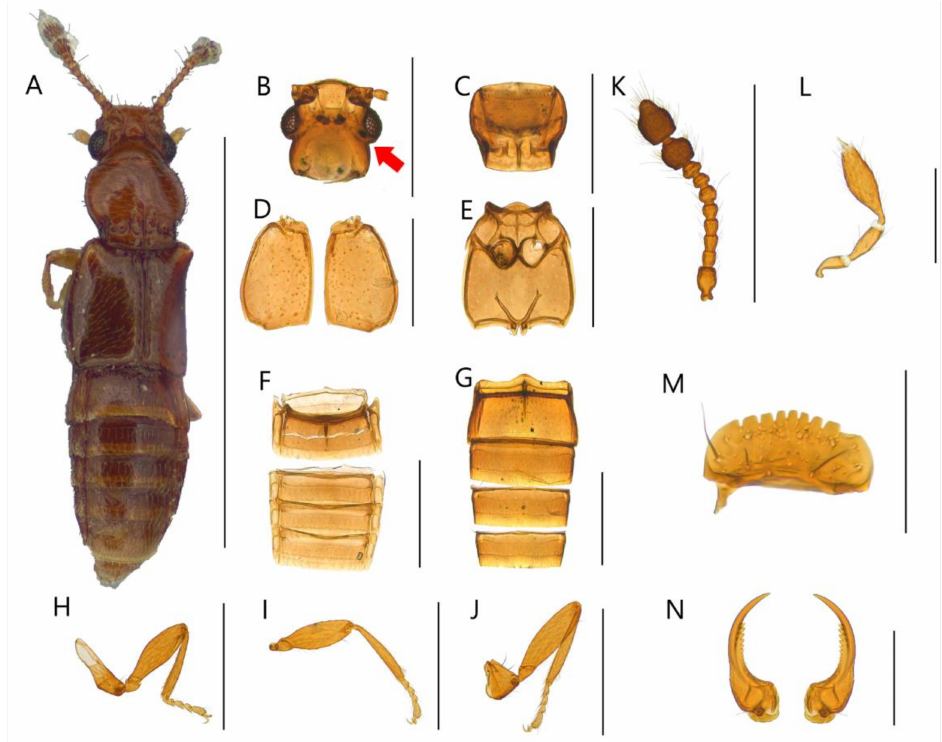
Figure 4. Male habitus of Edaphus suyuensis sp.n.: ( A ) dorsal view; ( B ) head; ( C ) pronotum; ( D ) elytra; ( E ) meso and metasternum; ( F ) abdominal tergites; ( G ) abdominal sternites; ( H ) fore leg; ( I ) middle leg; ( J ) hind leg; ( K ) antenna; ( L ) maxillary palp; ( M ) labrum; ( N ) mandibles. Scale bars: ( A ) = 1 mm; ( B – K ) = 0.3 mm; ( L – N ) = 0.1